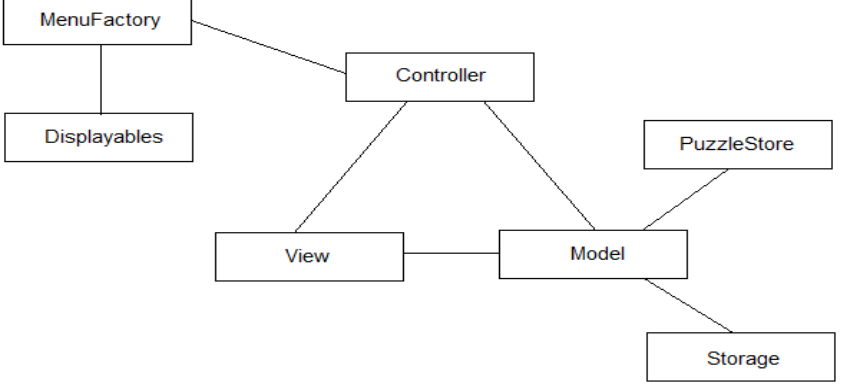
Figure 3. MVC architecture for Sudoku [41].